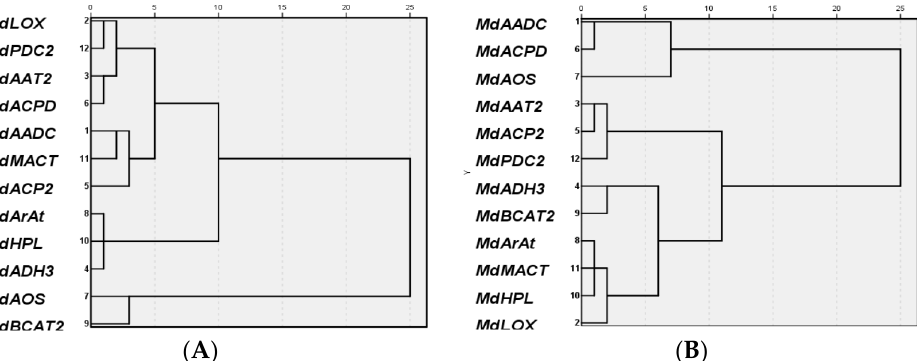
Figure 3. Cluster analysis of relative expression patterns of 12 genes related to the synthesis of volatile compounds in ( A ) “Ruixue” and ( B ) “Fuji” apple fruit.